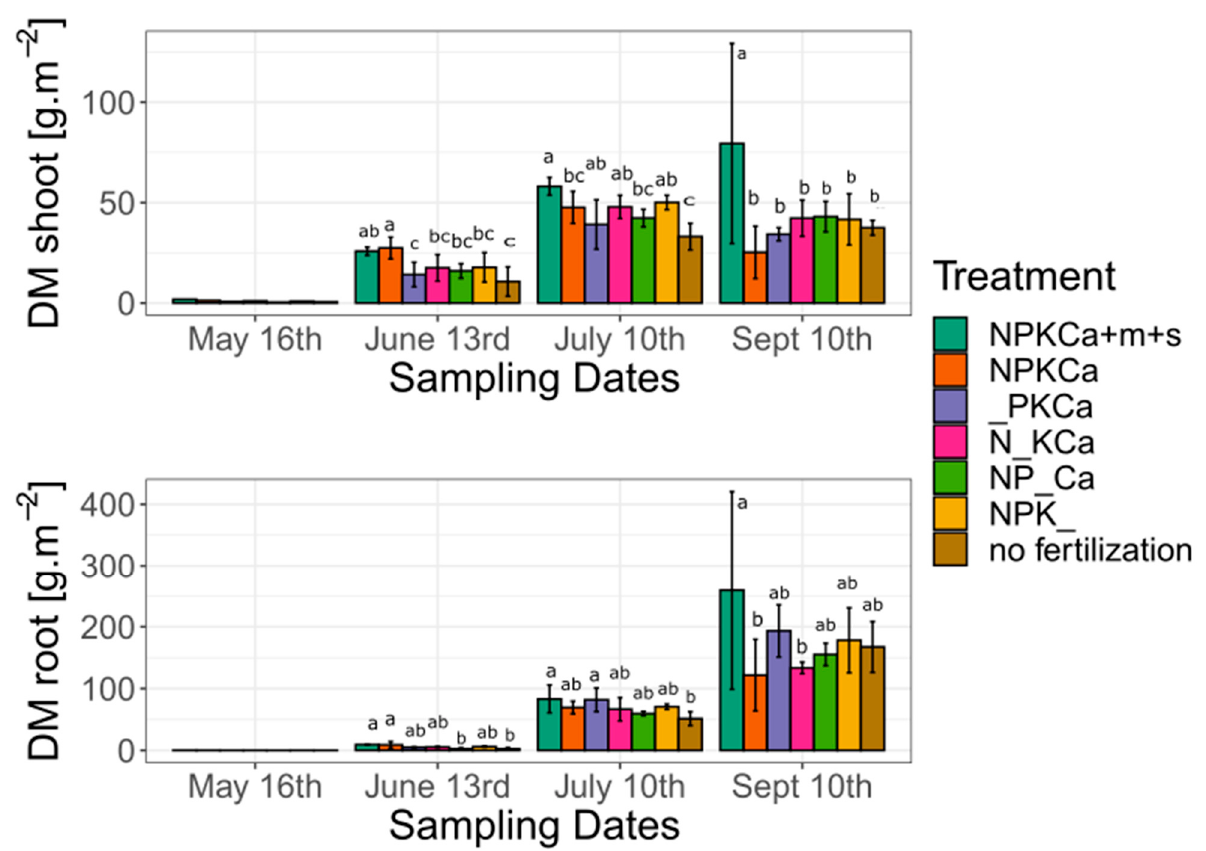
Figure 4. Mean values of the observed shoot and root dry matter weight of sugar beet at the four sampling dates in 2019 at the long-term fertilizer experiment Dikopshof, Germany. The error bars correspond to the 95% interval of confidence. Different letters indicate significant differences between treatments (ANOVA, α = 0.05).